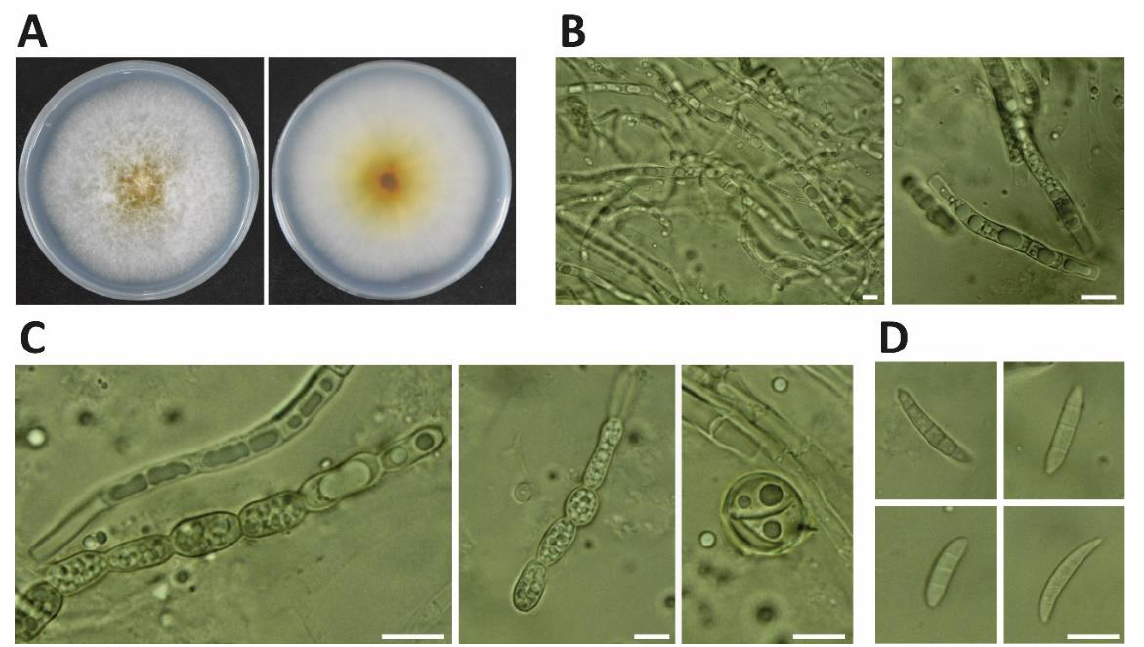
Figure 2. Morphological characteristics of Fusarium sulawense NJC31 isolated from soybean pods. ( A ) Colony of F. sulawense on PDA at 26 °C after incubation for 5 days. ( B ) Septate mycelium. ( C ) Linear and round chlamydospores (number of observations = 89). ( D ) Fusiform macroconidia (num- ber of observations = 56) (10 –15 μm in length) containing 3–5 septum separations. Bar = 10 μm.